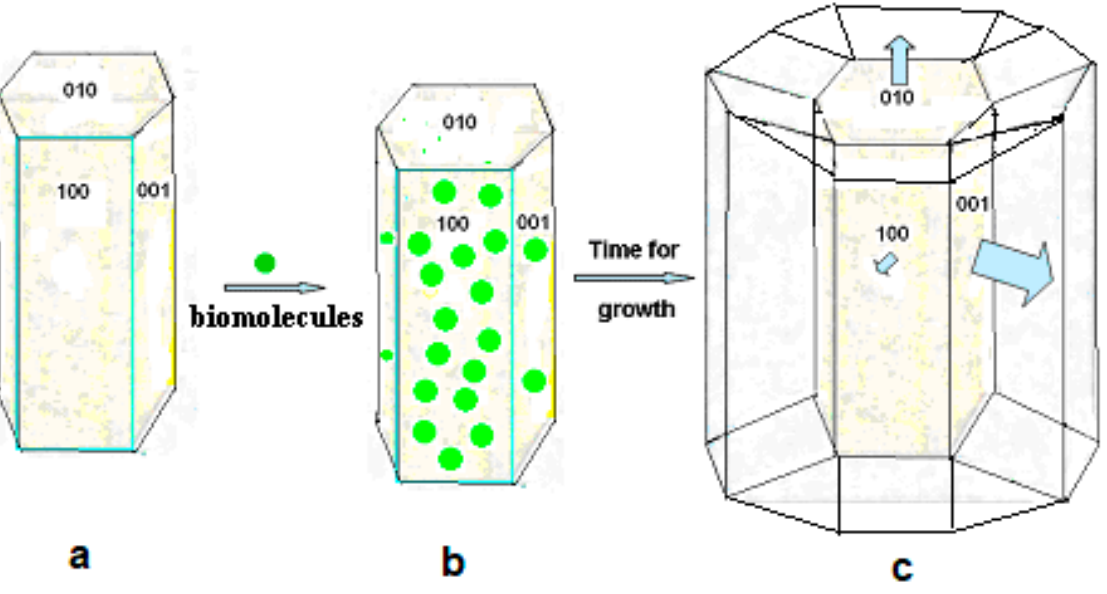
Figure 10. Schematic representation of HA growth on the deposition of small molecules at (100); (010), and (001) planes of HA. ( a ) Neat HA, ( b ) HA with deposited small molecules at different surfaces and ( c ) showing the formation of plate-like HA crystal. Reprinted with permission from Ref [45]. Copyright (2015) Royal Society of Chemistry.